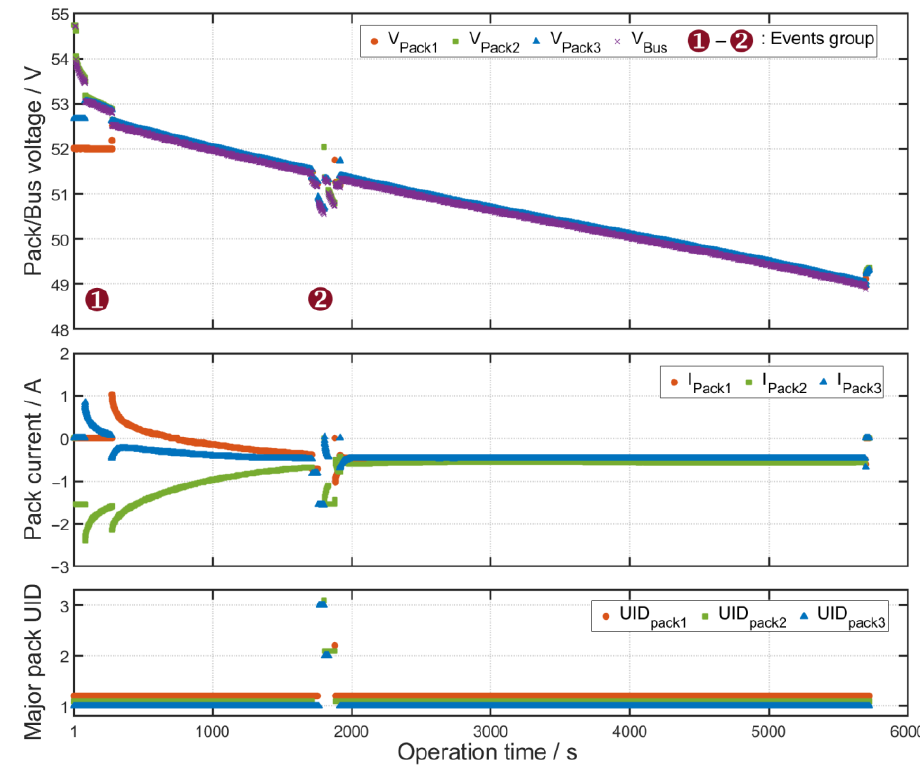
Figure 11. Data of a battery power network discharge cycle.